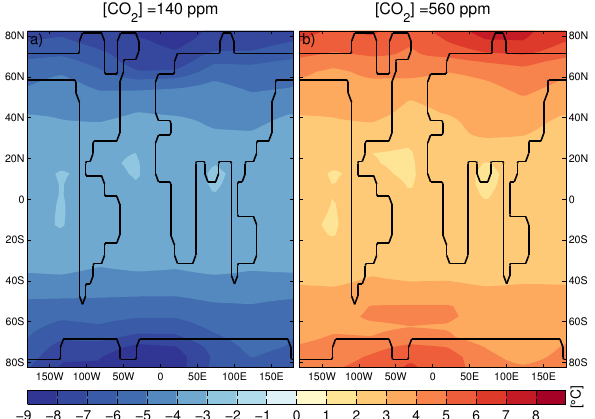
Fig. 4. Ensemble-mean annual precipitation anomalies relative to × CO × CO 2 and (b) 2 2 for the preindustrial climate ( R - C ) for (a) 1 2 experiments with prescribed vegetation from the control. All values are significant at the 95%